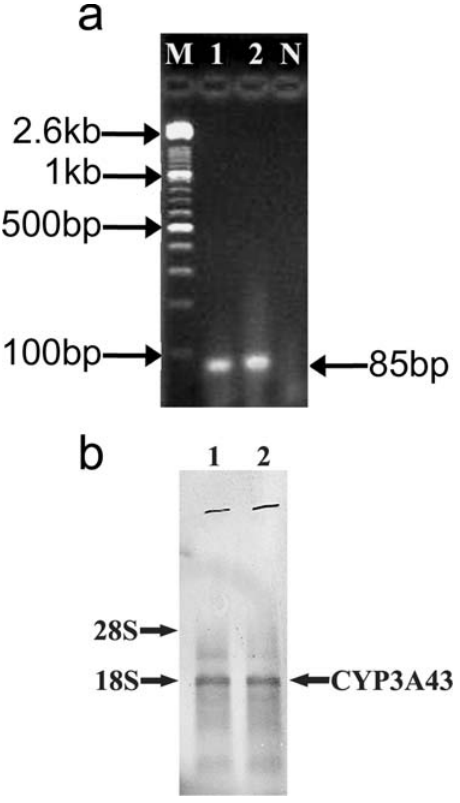
Figure 1. Constitutive expression of CYP3A43 mRNA in human brain cortex. (a) Total RNA was extracted from human brain cortex of 2 subjects and the 3 9 -UTR of CYP3A43 was amplified by RT-PCR (lanes 1 and 2). Lane N denoted reaction performed without template DNA. The size of the PCR product was 85bp. (b) Total RNA from human brain cortex was electrophoresed, transferred to positively charged nylon membrane and hybridized with antisense riboprobe prepared using the partial cDNA to CYP3A43. The mobility of 18S and 28S ribosomal RNA on the agarose gel is indicated.